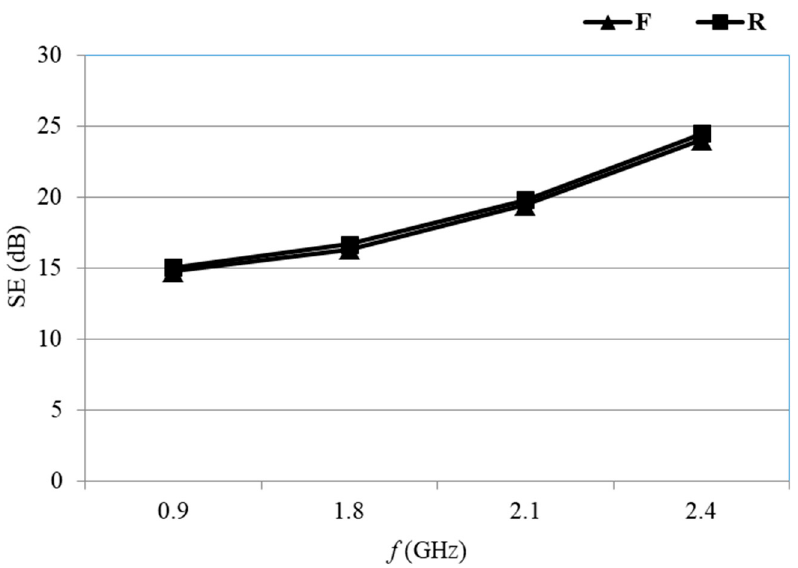
Figure 6. Initial SE of the face (F) and reverse (R) sides of the PA/Ag fabric at frequencies of 0.9 GHz, 1.8 GHz, 2.1 GHz, and 2.4 GHz.